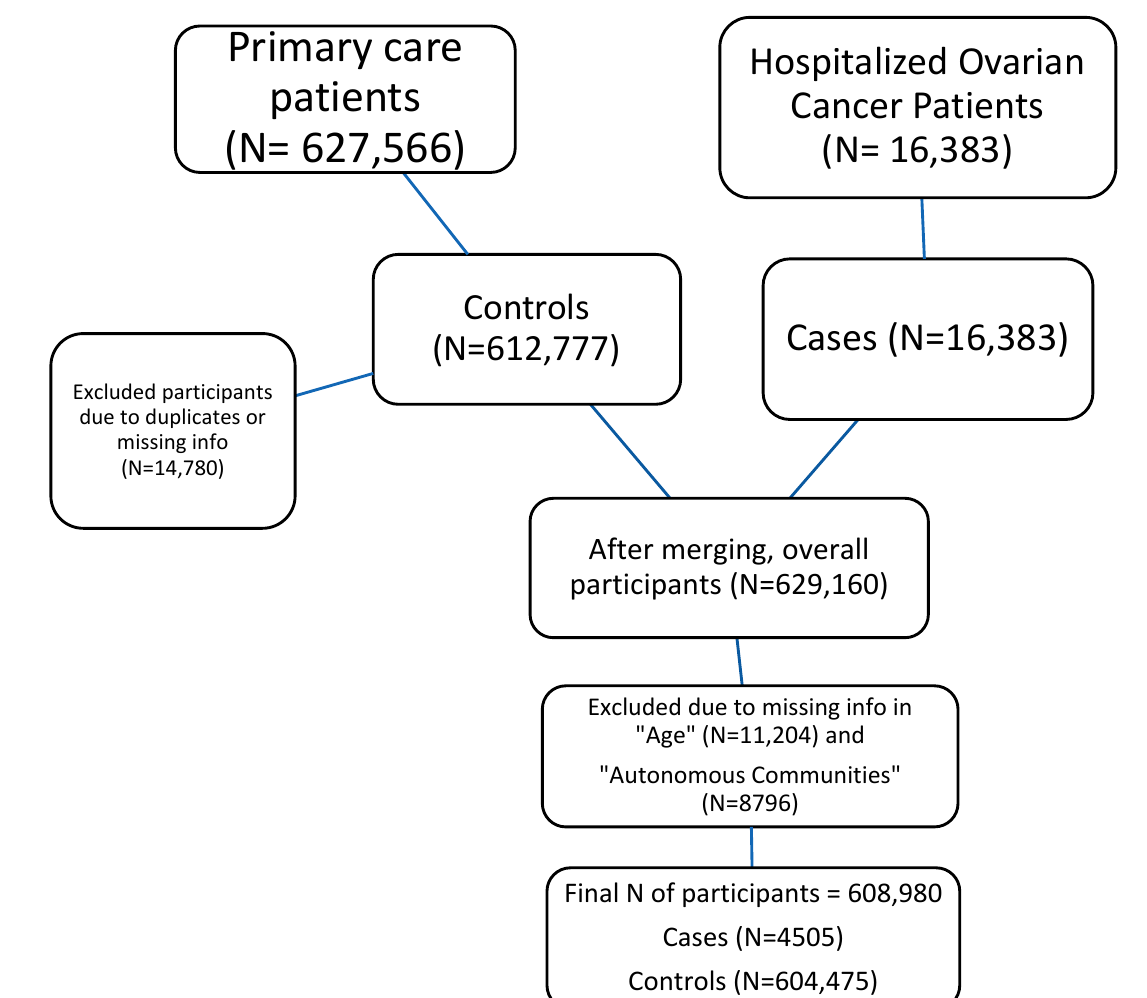
Figure 1. Illustrating the study design.